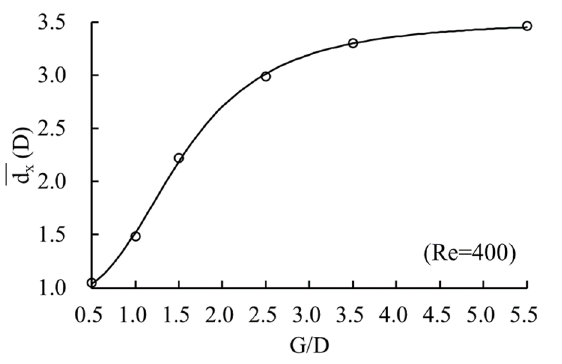
Figure 7. Average distance of the vortex centres of the flow around a square cylinder d x along the flow direction under different boundary constraint degrees when R e = 400 .